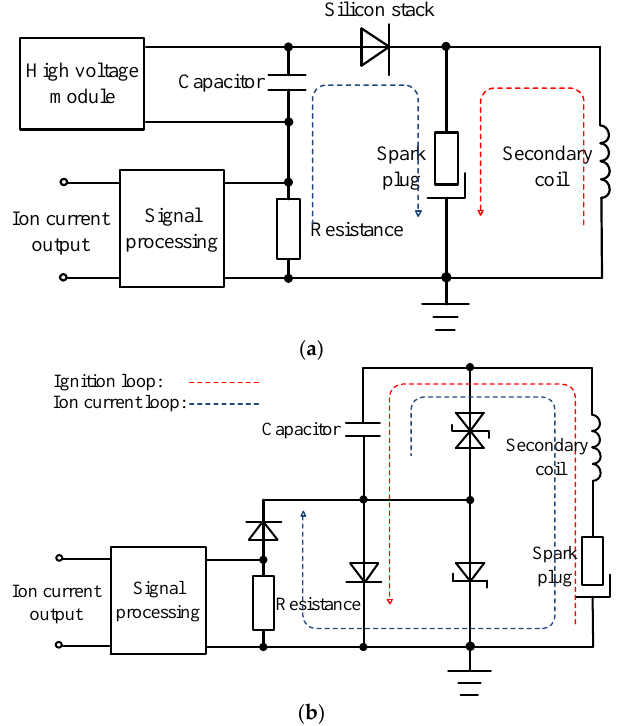
Figure 2. Schematic of two ion current detection systems: ( a ) DC-Power type; ( b ) Capacitive